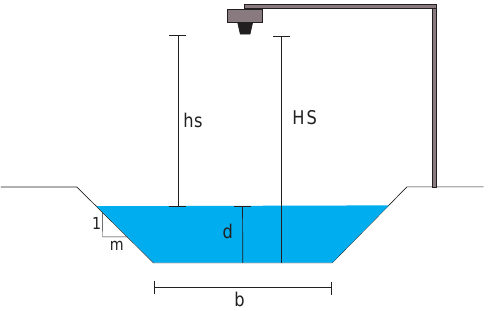
Fig.2. Sensor arrangement on the irrigation canal. d = canal water tie-back; HS = distance between the sensor and the canal base; hs = distance between the sensor and the water mirror of the canal; b = width of the base of the canal; m = inclination of the